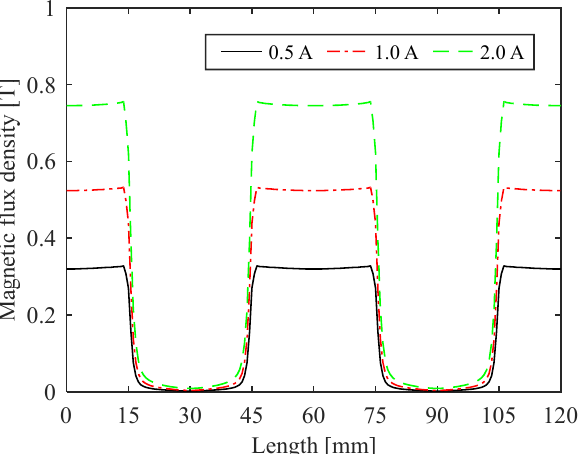
Figure 2. Magnetic flux density along the annular gap for different excitation currents.